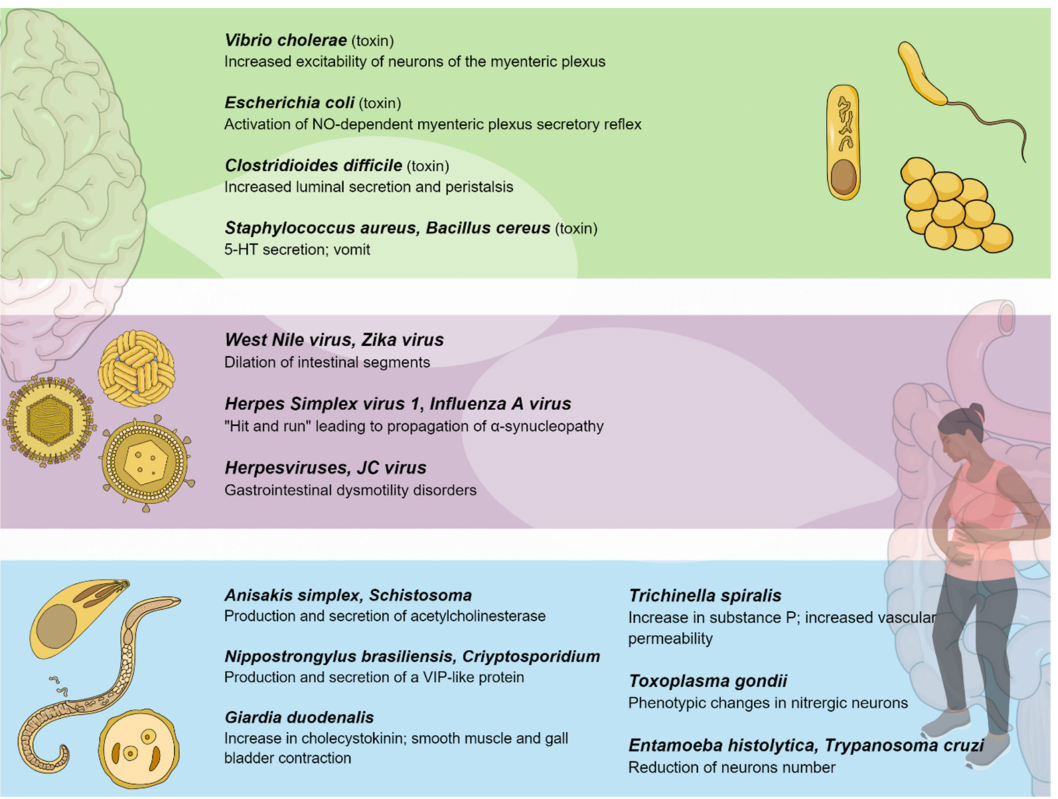
Figure 2. Pathogenic bacteria, viruses, and parasites primarily a ff ecting the gastrointestinal system interact with the enteric nervous system, establishing a connection between the gut and the central nervous